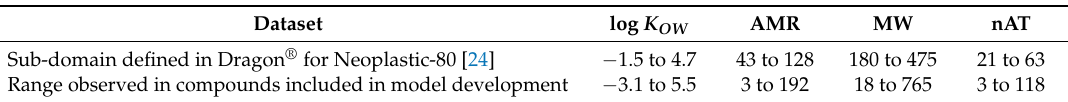
Table 6. Ranges of molecular descriptors for sub-domain of antineoplastic properties and those for model-developing compounds a .